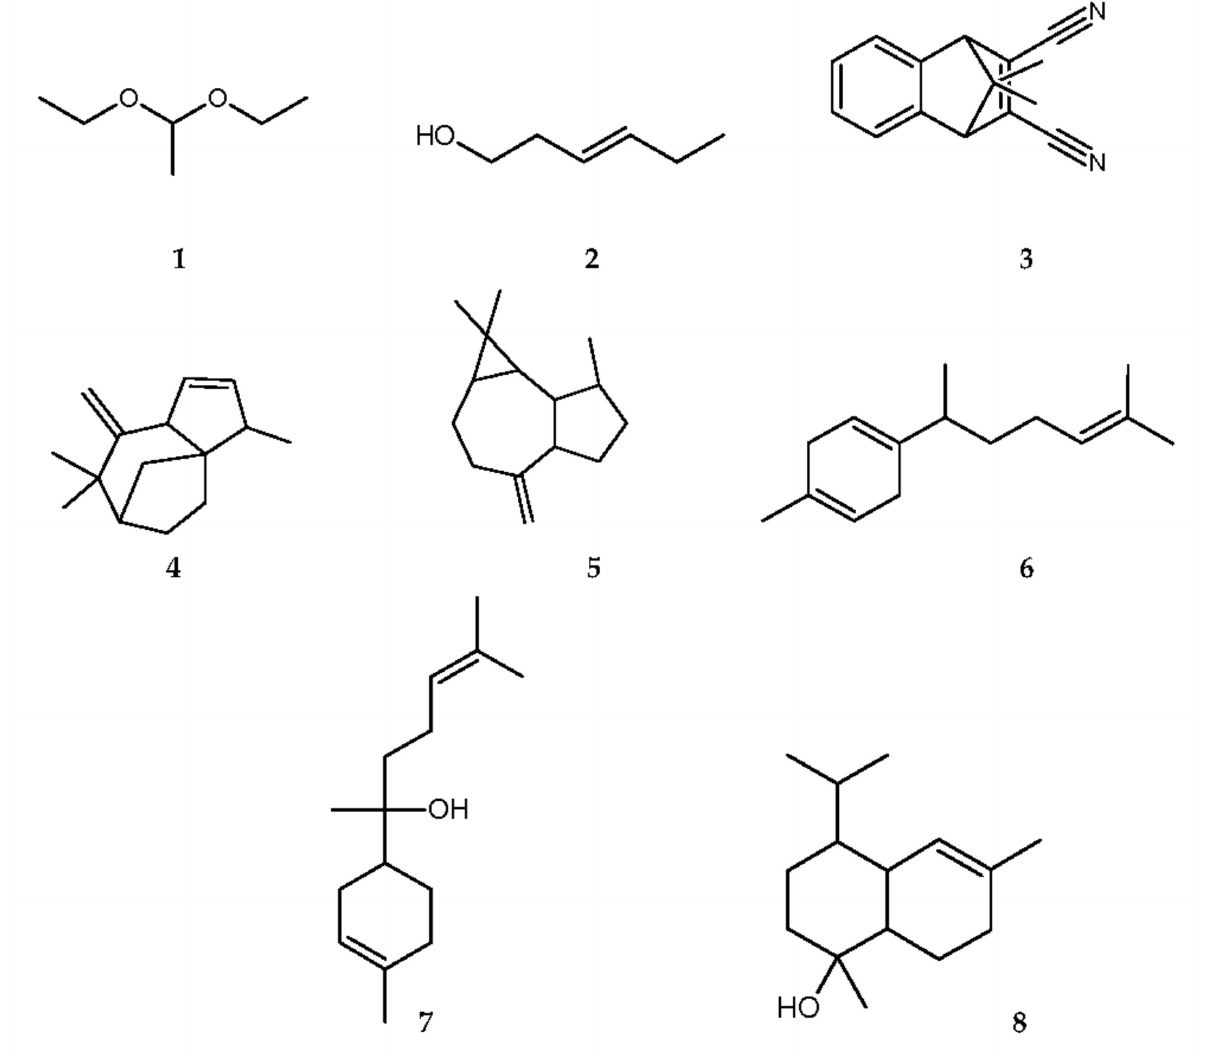
Figure 1. Structures of identified compounds (1–8) from Campomanesia lineatifolia fresh leaves essential